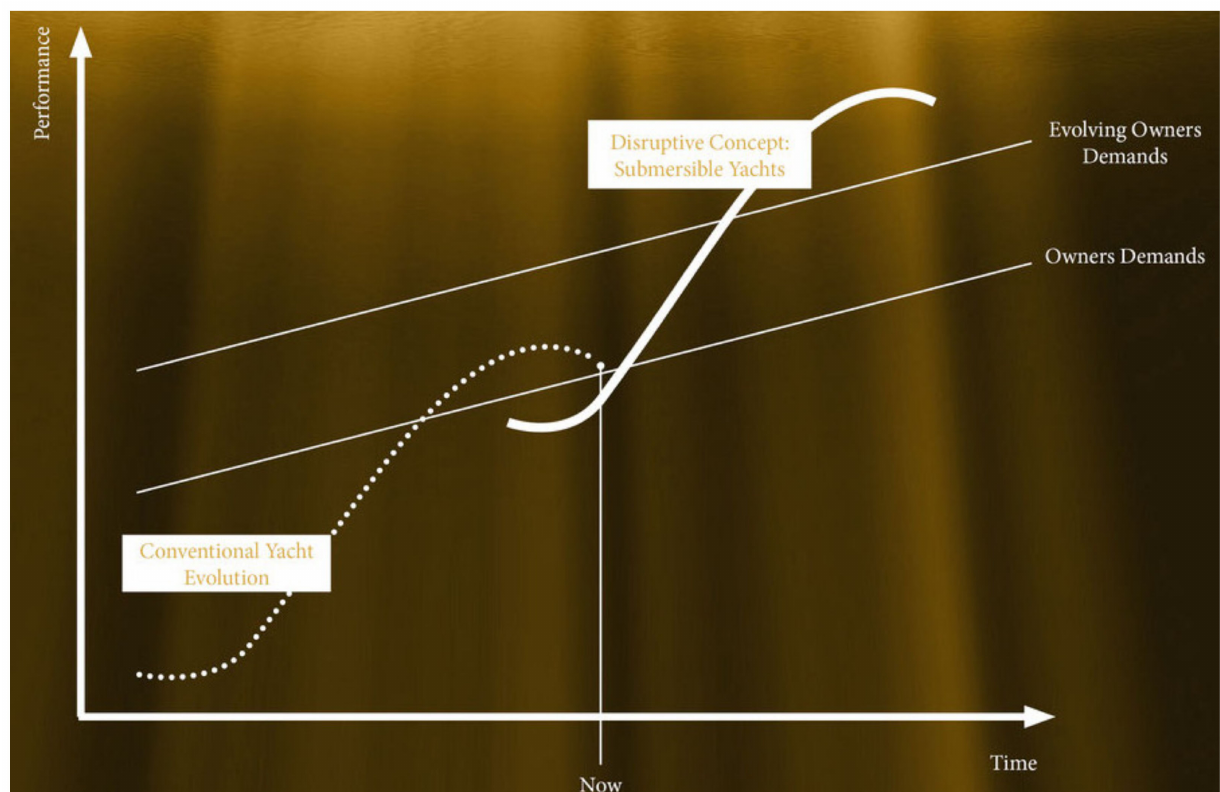
Figure 22. The impact of evolution and sustaining technological changes with disruptive concepts to meet market demands and product performance (Courtesy: